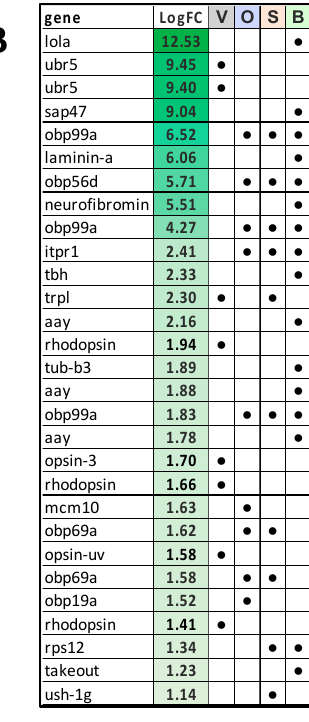
Figure 6. Unigenes associated with sensory processes, behavior, learning and memory that were significantly upregulated in EHDV-2 infected midges. Di ff erentially-expressed unigenes were manually inspected, catalogued and categorized to present sets associated with sensory processes (vision, olfaction, other) and brain functions (learning, memory, behaviors). ( A ) Of the 29 unigenes that were upregulated with EHDV-2 infection: 8 associated with vision, 9 associated with olfaction, 10 associated with other sensory functions (e.g., gustatory, touch), and 16 to brain, memory and / or learning. ( B ) Log 2 -FC in expression of unigenes associated with vision (V), olfaction (O), other sensory (S) and brain functions (B) are given. As both panels indicate, many of these unigenes have overlapping functions. Further details including functional roles for each unigene can be found in Supplementary Table S8.